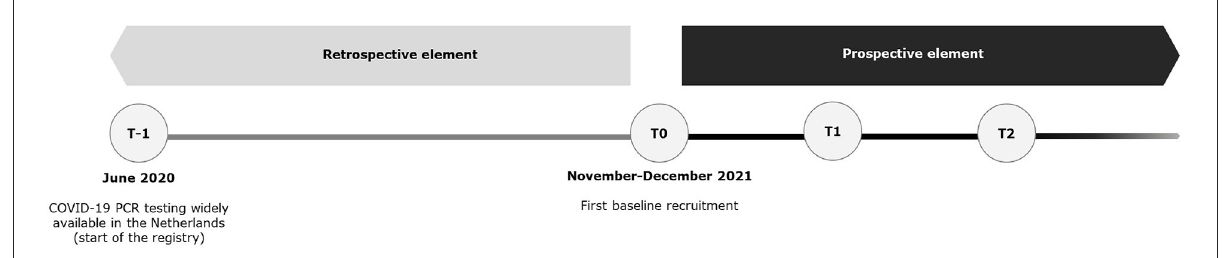
FIGURE1 Overview of the prospective and retrospective elements of the PRIME post-COVID study design.